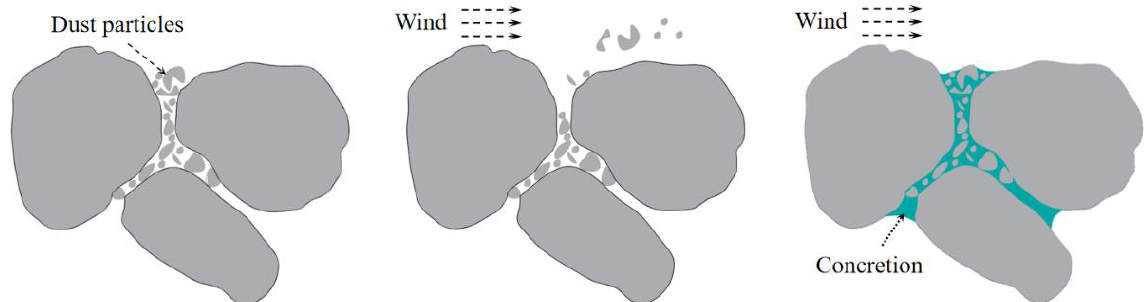
Figure 4. Principle of dust control in the non-disturbed area.